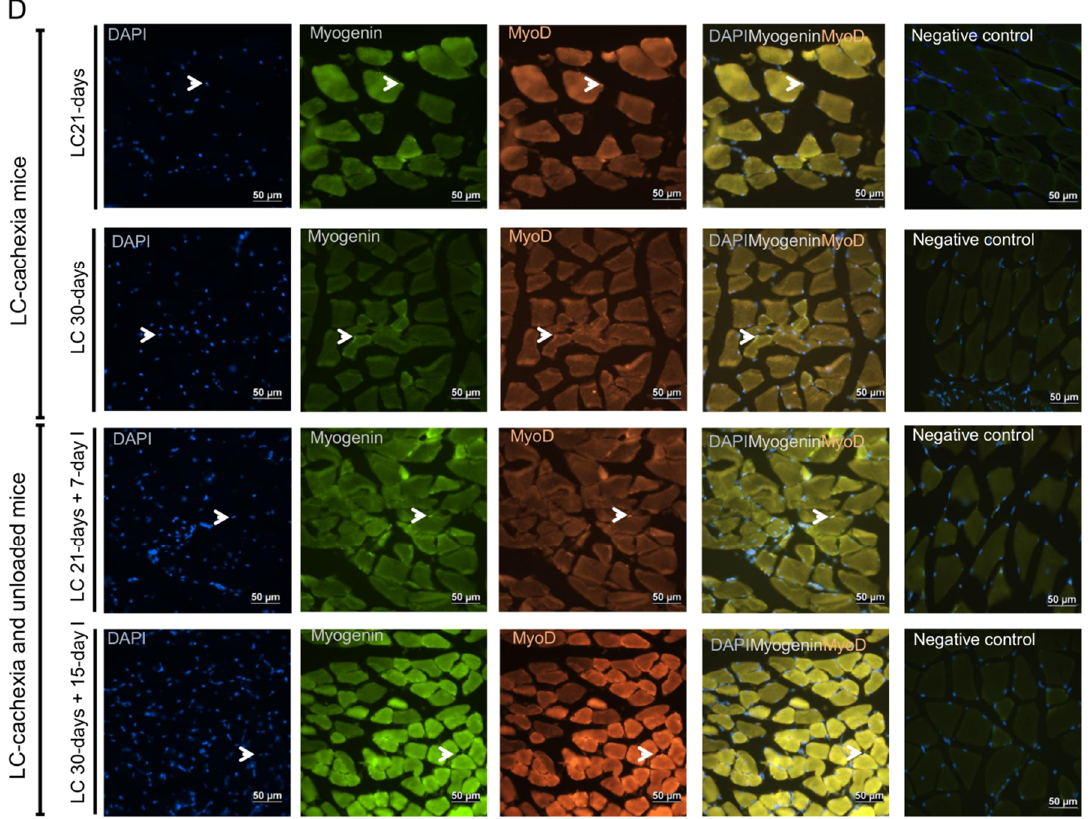
Figure 8. ( A ) Representative images of immunofluorescence staining of DAPI (left panels), Pax-7 (middle-left panels), MyoD (middle panels) and cells positively stained for both Pax-7 and MyoD markers (middle-right panels), and negative controls (right panels) in the gastrocnemius muscle of the NI-control mice and the unloaded mice (7-day I and 15-day I groups of animals). Arrows indicate double-stained nuclei for both Pax-7 and MyoD positive cells (myoblast). ( B ) Representative images of immunofluorescence staining of DAPI (left panels), Pax-7 (middle-left panels), MyoD (middle panels) and cells positively stained for both Pax-7 and MyoD markers (middle-right panels), and negative control (right panels) in the gastrocnemius muscle of the LC-cachexia mice (LC 21-days, LC 30-days) and those bearing the two conditions (LC-cachexia and unloading, LC 21-days + 7-day I and LC 30-days + 15-day I groups of mice). Arrows indicate double-stained nuclei for both Pax-7 and MyoD positive cells (myoblast). ( C ) Representative images of immunofluorescence staining of DAPI (left panels), myogenin (middle-left panels), MyoD (middle panels) and cells positively stained for both myogenin and MyoD markers (middle-right panels), and negative control (right panels) in the gastrocnemius muscle of the NI-control mice and the unloaded mice (7-day I and 15-day I groups of animals). Arrows indicate double-stained nuclei for both myogenin and MyoD positive cells (myocytes). ( D ) Representative images of immunofluorescence staining of DAPI (left panels), myogenin (middle-left panels), MyoD (middle panels) and cells positively stained for both myogenin and MyoD markers (middle-right panels), and negative control (right panels) in the gastrocnemius muscle of the LC-cachexia mice (LC 21-days, LC 30-days) and those bearing the two conditions (LC-cachexia and unloading, LC 21-days + 7-day I and LC 30-days + 15-day I groups of mice). Arrows indicate double-stained nuclei for both myogenin and MyoD positive cells (myocytes). Definition of abbreviations : Pax-7, paired box -7; MyoD, myogenic differentiation 1; DAPI, 4′,6-diamino-2-fenilindol; NI, non-immobilized; LC, lung cancer; I, immobilized.